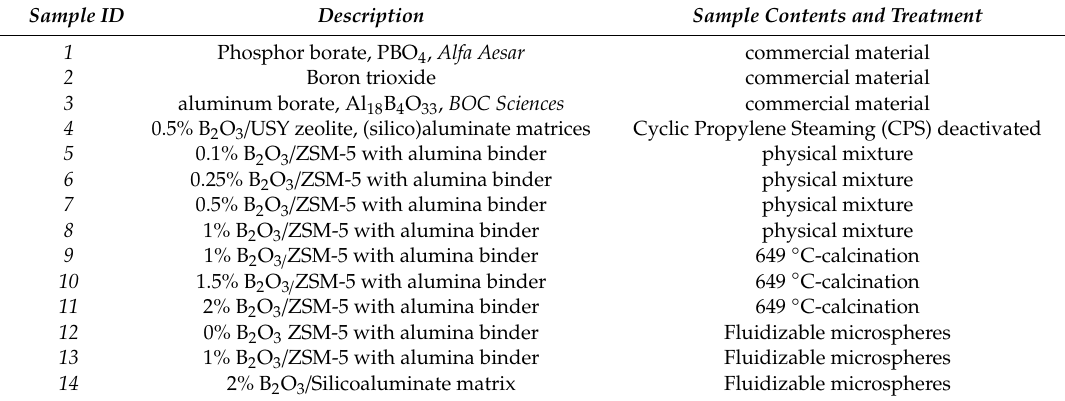
Table 1. Powder sample IDs and detail